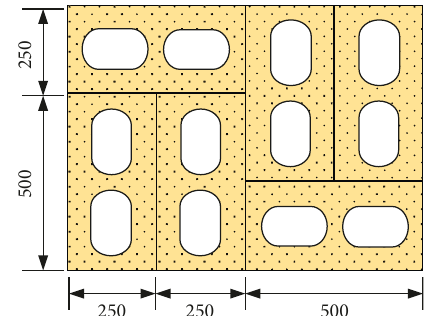
Figure 12: Plane layout of blocks.